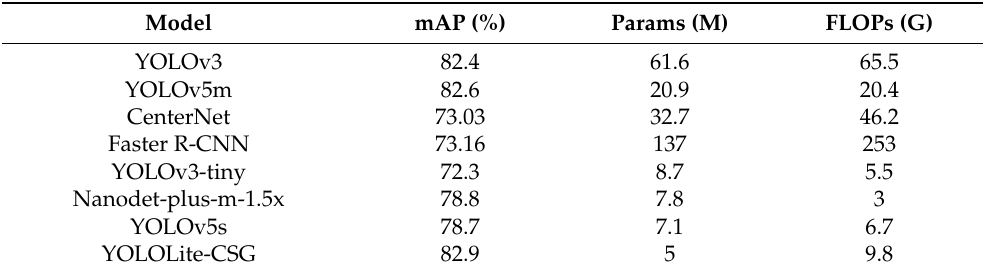
Table 5. Performance comparison of the YOLOLite-CSG with existing major object detection methods for crop pest detection tasks. Model mAP